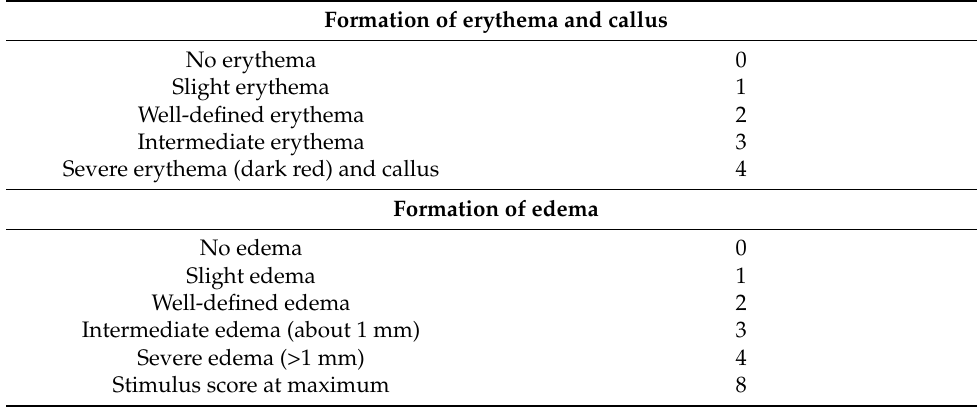
Table 2. Intradermal reactivity score evaluated by the degree of formation of erythema and callus, and